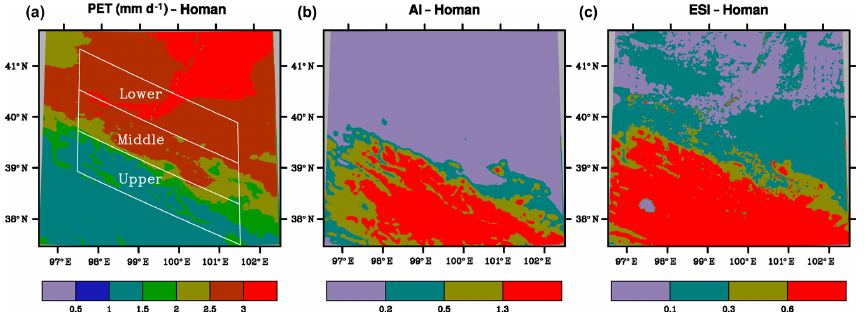
Figure 7. Spatial distributions of potential evaporation (mmd − 1 ), aridity index and evaporative stress index with PET estimated using the Hamon method. Averaged over 1980–2010. The Heihe River basins are shown in panel (a) . The color bars from left to right for AI and ESI are arid, semiarid, semihumid and humid climate. Table 3. Regional average (AVE), standard deviation (SD), and coefficient of variation (CV) for potential evapotranspiration (PET, mmd − 1 ), aridity index (AI), and evaporative stress index (ESI). A, SA, SH, and H represent arid, semiarid, semihumid, and humid climate, respectively. PET Basin PET AI ESI AVE SD CV AVE SD CV AVE SD CV Upper 2.12